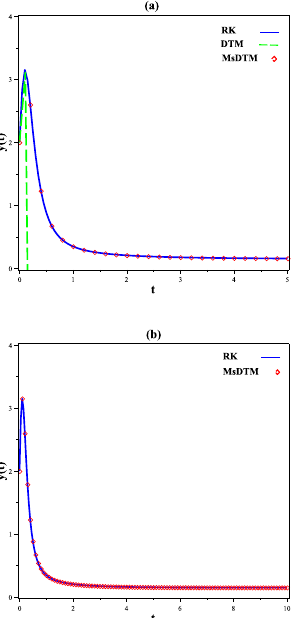
Figure 1: The density of the birds infected with avian influenza with r 0 = 1.06 and R 0 ≈ 7.1